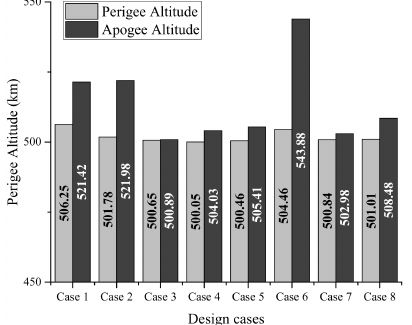
Figure 8. The orbital altitude of design